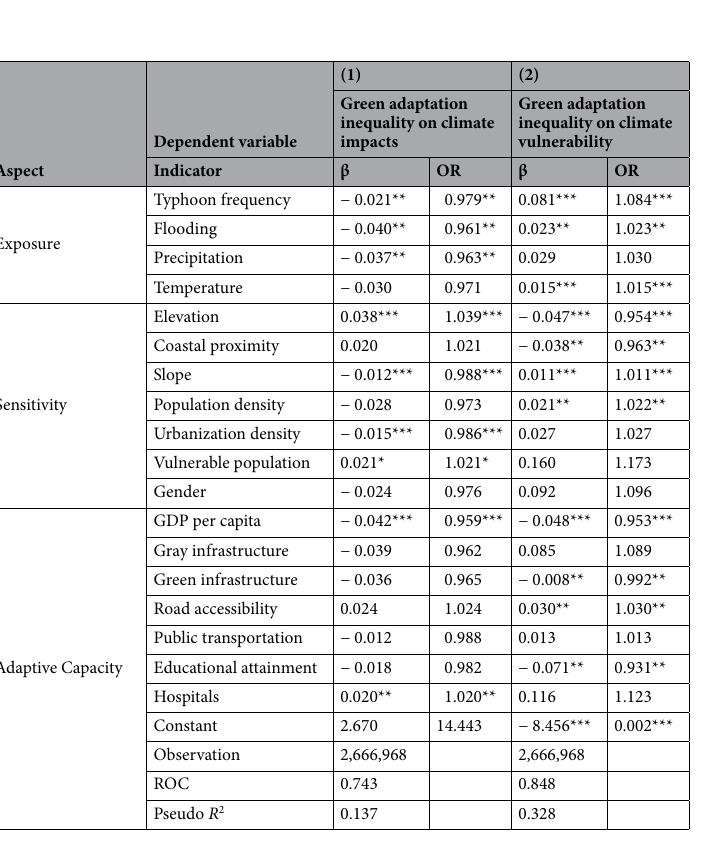
Table 2. Results of logistic regression for green adaptation inequalities (2010–2020). β = coefficient of independent variables; OR (Odds Ratio) indicates the change in the odds ratio associated with a unit change in the predictor variable; All independent variables are standardized values calculated by Eq. (2) (Methods); ROC (Relative Operating Curve) is a measure of independent variables’ interpretability on the dependent variable; Standard errors are clustered at the township level; * p < 0.10, ** p < 0.05, *** p <